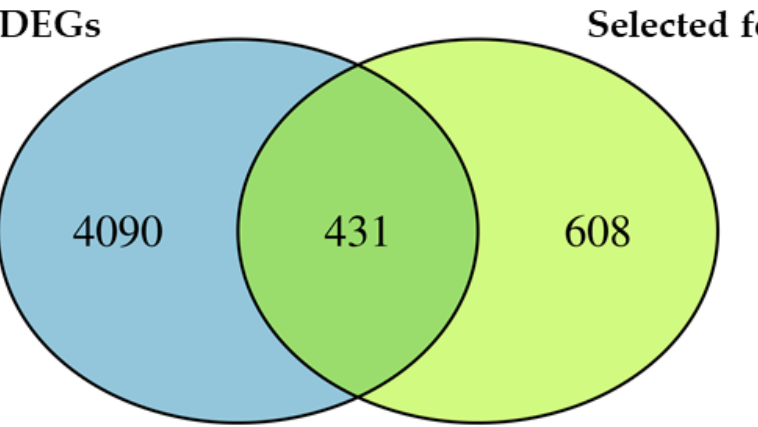
Figure 2. Venn diagram for distribution of DEGs and selected features. Among all the 4521 DEGs, the 4090 in the blue section are identified exclusively as DEGs. On the other hand, the 608 features in the green section are not identified as DEGs. Interestingly, 431 DEGs are highlighted in both the sections (intersection). Specifically, the genes included in the intersection are identified both as DEGs in the differential analysis and as important features by the model.